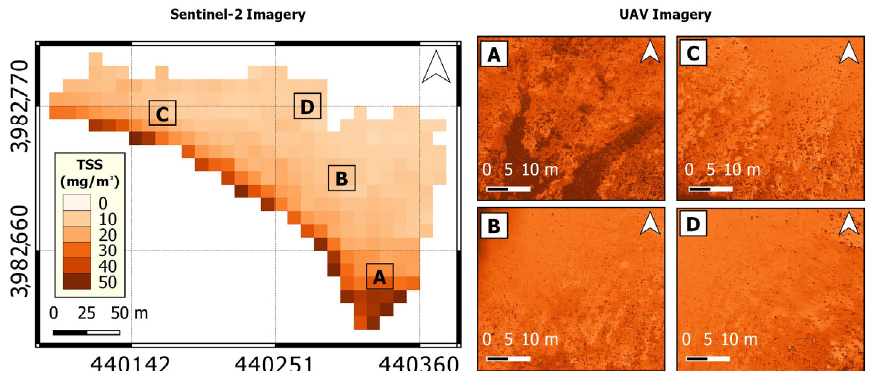
Figure 8. Spatial distribution of TSS for Cirkewwa using the [33] algorithm. The S2L2–TSS map is on the left, and subplots ( A – D ), referring to zoomed TSS UAV data, are on the right.